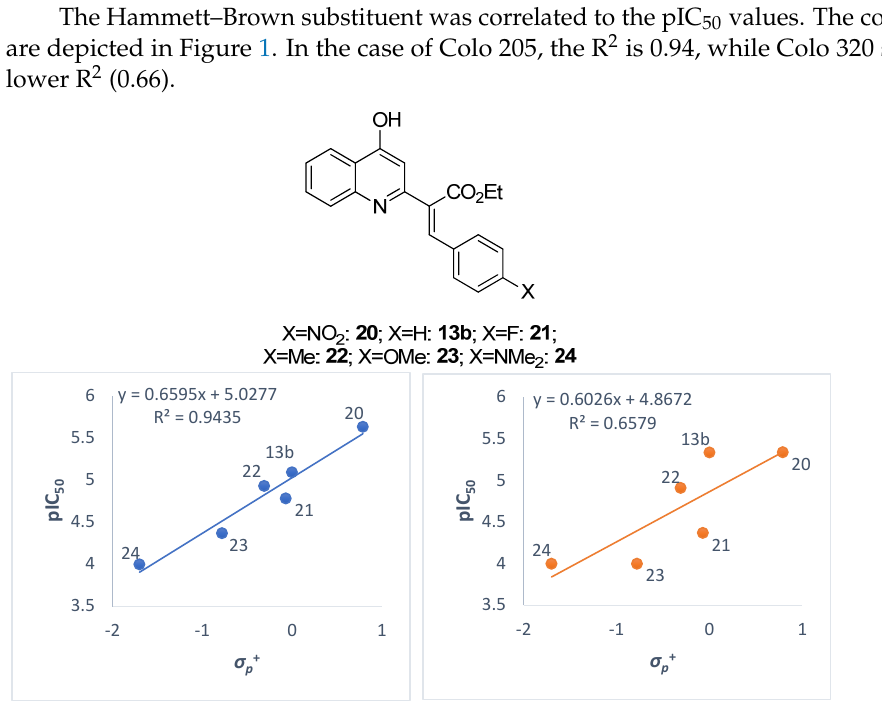
Figure 1. A correlation of the Hammet–Brown constant ( σ p + ) and pIC 50 for compounds 13b , 20 – 24 ; regression lines and regression coefficients are given.